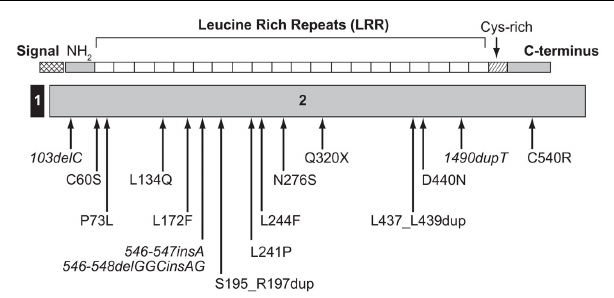
FIGURE 3 | Schematic representation of theALS protein indicating the location of identified human IGFALS mutations. The IGFALS is composed of two exons, with five amino residues of the ALS signal peptide encoded by exon 1 and the first five amino residues of exon 2 and the remainder of the ALS protein encoded by exon 2. ALS, acid-labile subunit; NH 2 , N-terminal